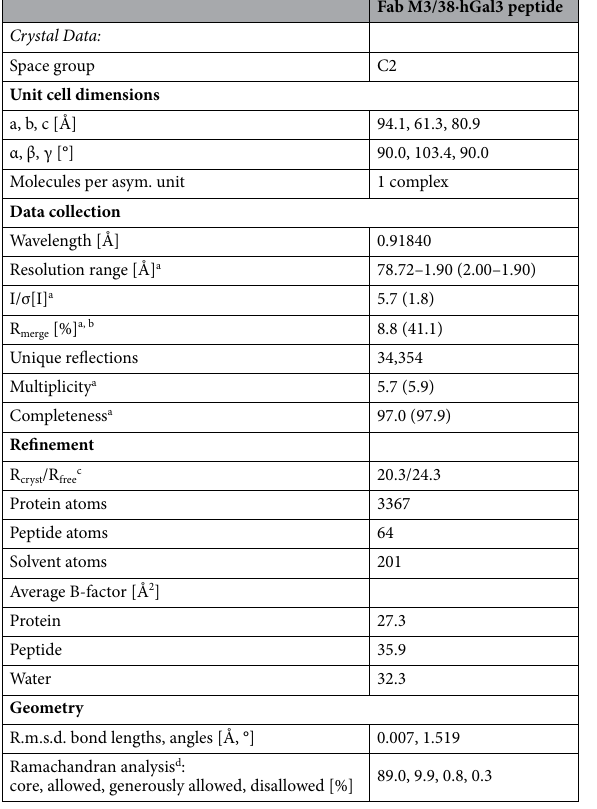
Table 1. Crystallographic analysis and refinement statistics. a Values in parentheses are for the